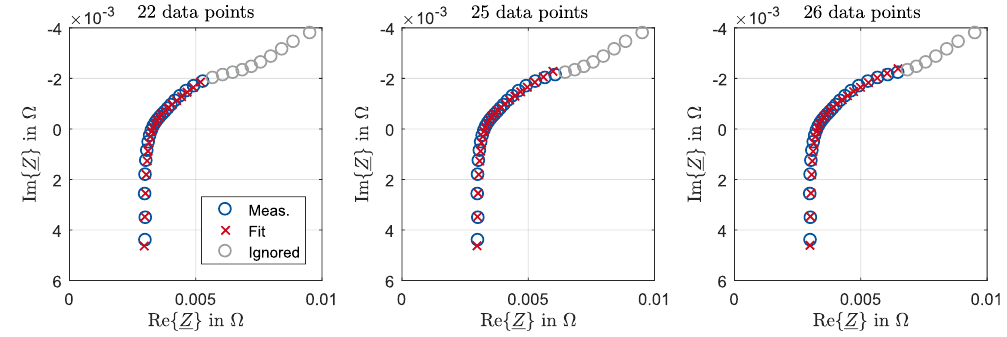
Figure A3. The impedance spectrum of TC 1 in hard AK3.4 recorded after the charging phase (30FCE) was fitted three times, always with a different number of data